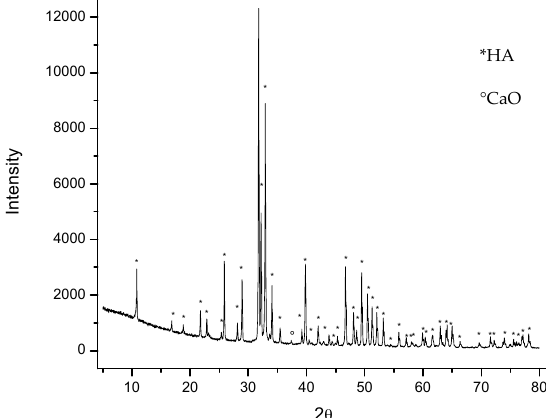
Figure 1. X-ray power diffraction (XDR) pattern of Hydroxyapatite (HA) obtained from bovine bones at 800 °C.